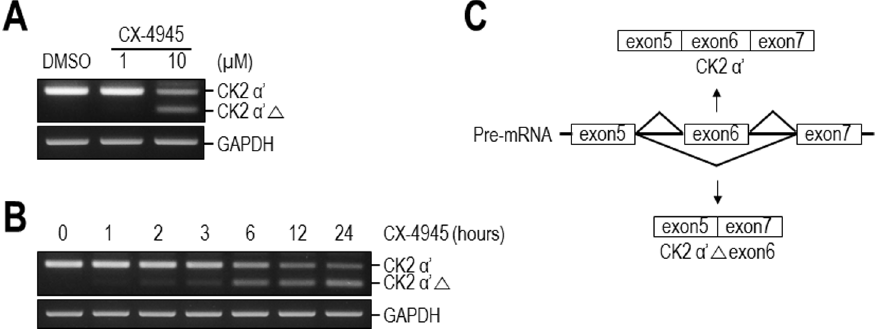
Figure 1. Effect of CX-4945 on pre-mRNA splicing. (A) CX-4945 induces expression of an unexpected CK2 a 9 transcript, CK2 a 9 g . RT-PCR corresponding to exons 5–6–7 was performed with total RNA from DMSO- or CX-4945-treated 293T cells. (B) CX-4945 rapidly induces the expression of CK2 a 9 g . 293T cells were treated with CX-4945 for the times indicated prior to RNA preparation and RT-PCR analysis. GAPDH mRNA was analyzed as a control. (C) Analysis of the DNA sequence of CK2 a 9 g revealed that it represents the exon6-skipped product (CK2 a 9 g exon6) of CK2 a 9 pre- mRNA. The normally spliced (CK2 a 9 ) and alternatively spliced (CK2 a 9 g exon6) products are illustrated schematically.